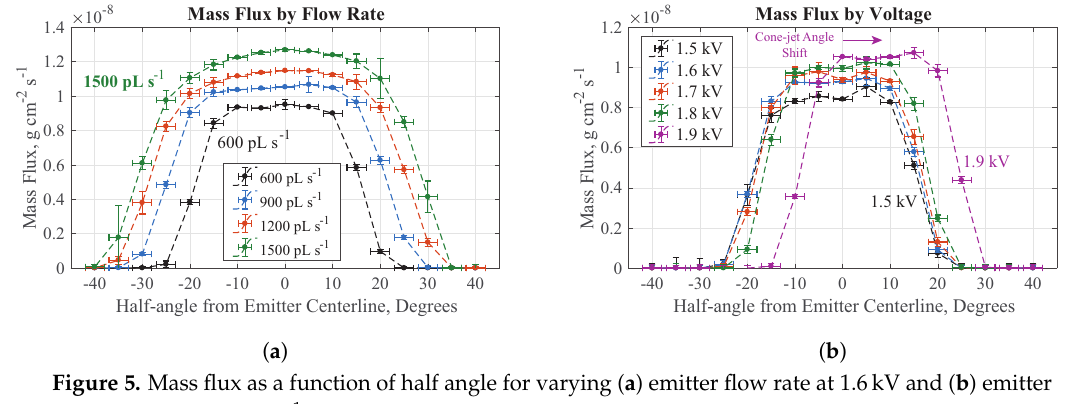
Figure 5. Mass flux as a function of half angle for varying ( a ) emitter flow rate at 1.6kV and ( b ) emitter bias voltage at 600pLs − 1 . The plume measurements are reproduced from Ref.